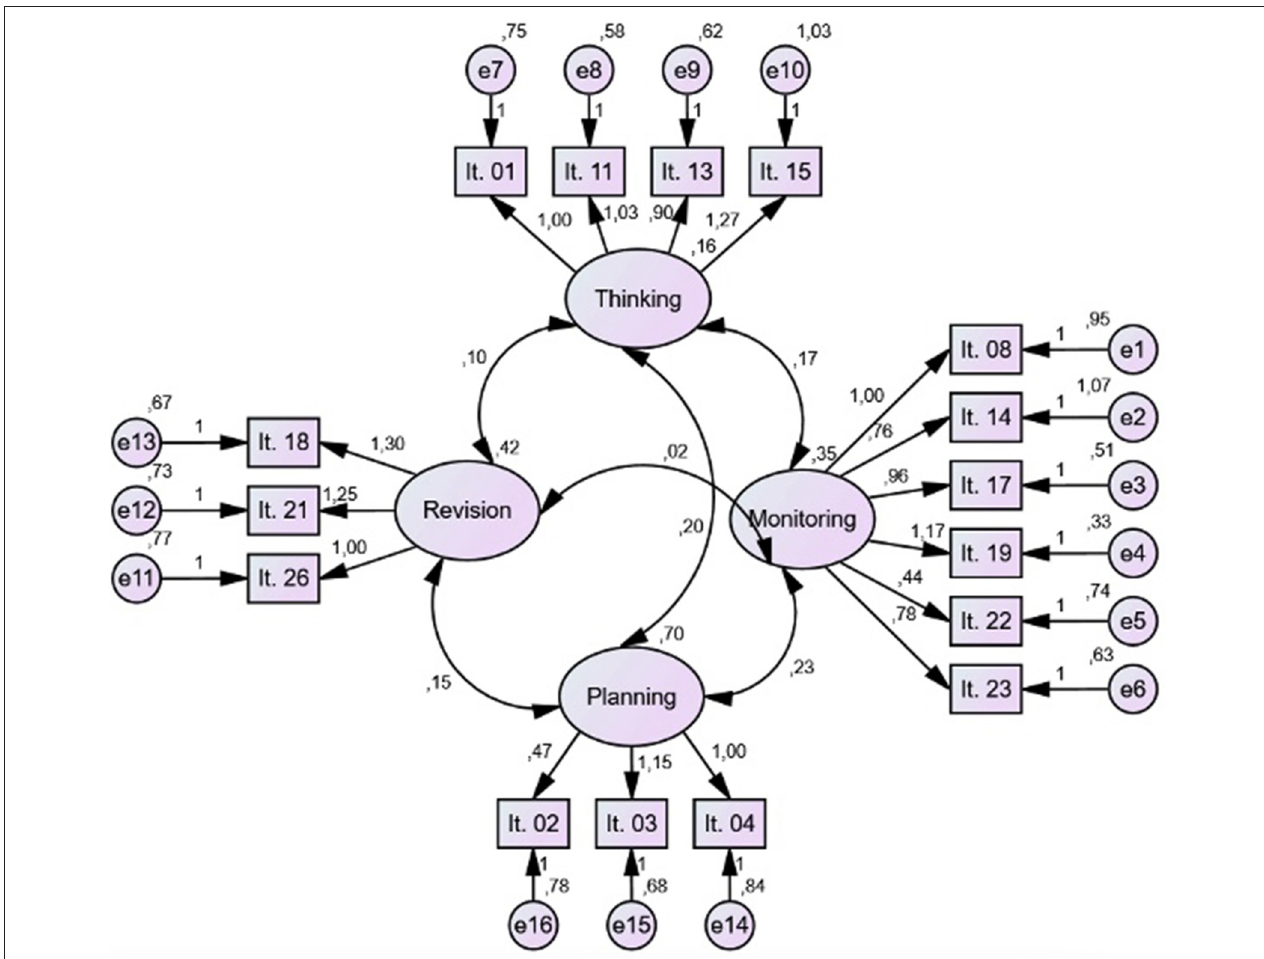
FIGURE 2 | Path diagram of the hypothesized model. Confirmatory Factor Analysis of the questionnaire.